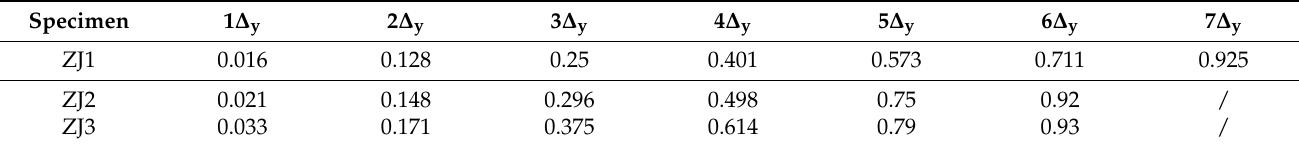
Table 4. Damage index values of the precast